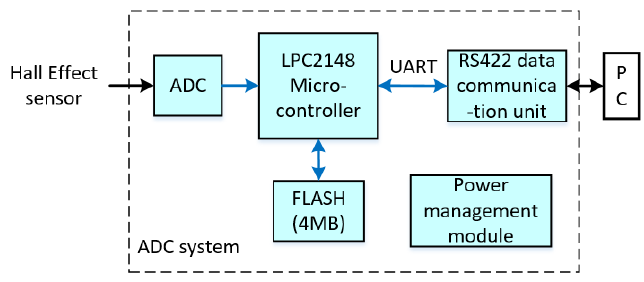
Figure 19. Block diagram of the Analog-to-Digital Converter (ADC) system.